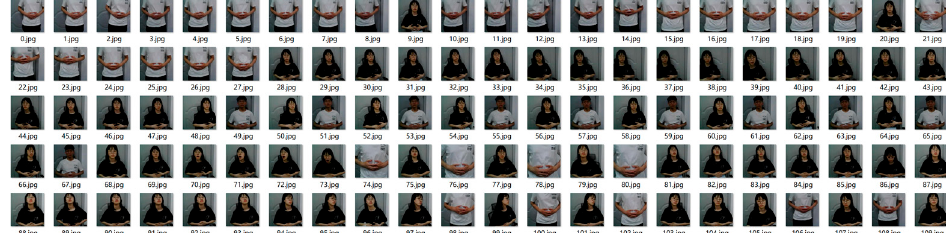
Figure 7. Annotation example of the database. These are the sign language that needs to be recog- nized.